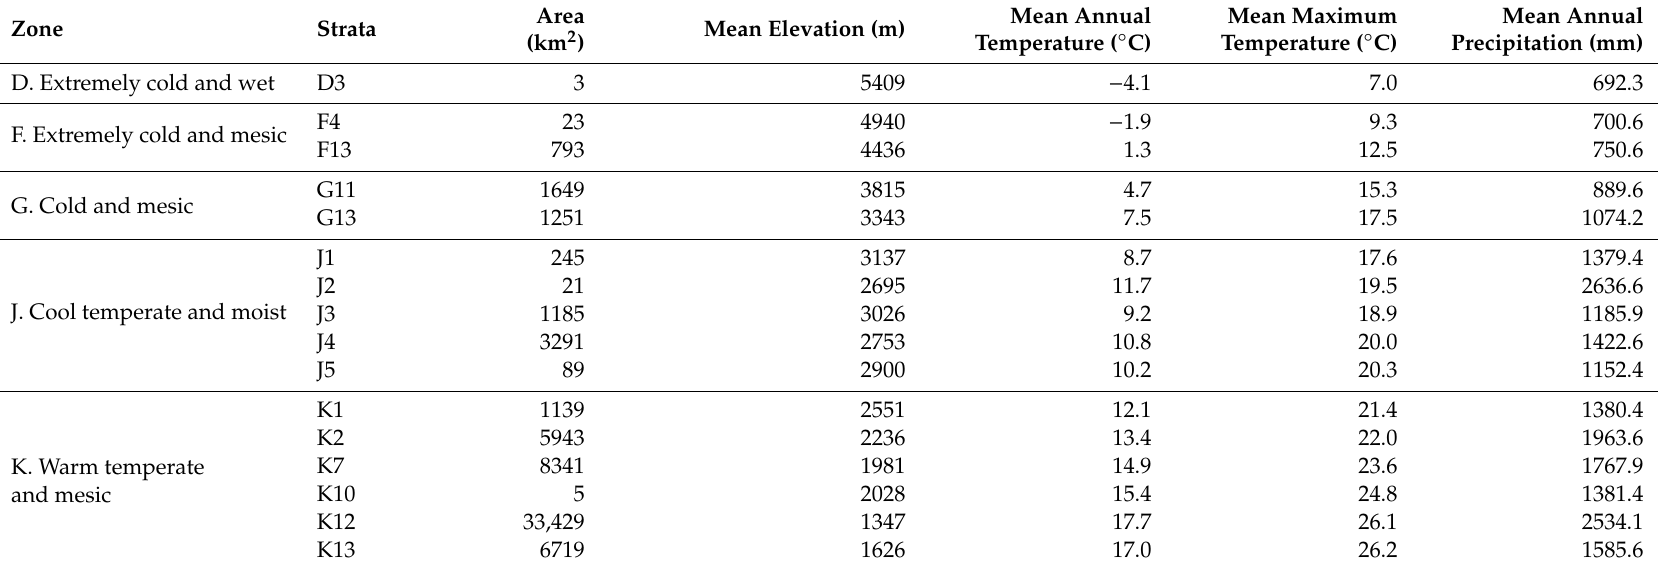
Table 2. Characteristics of the bioclimatic strata in Myanmar based on climate data from 1960 to